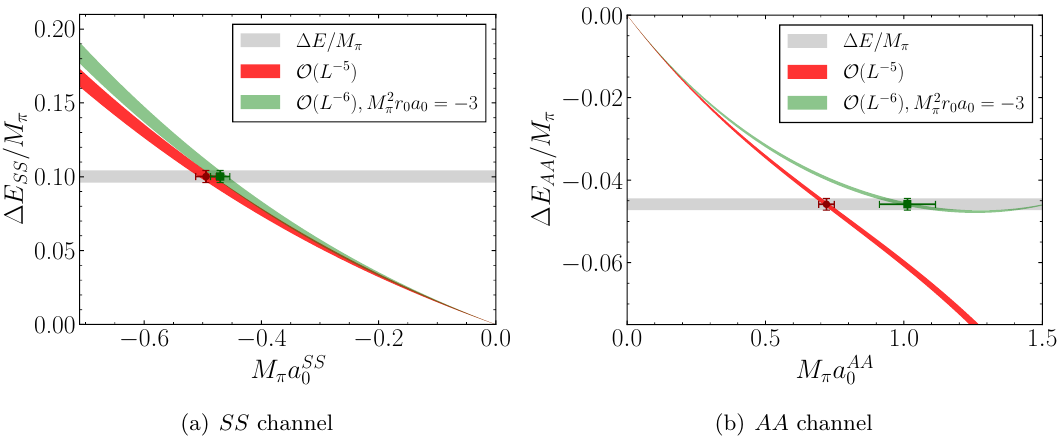
Figure 6 . Comparison between the O ( L − 5 ) (red) and O ( L − 6 ) (green) threshold expansion given in eq. (3.4). The left panel corresponds to the 3A10 ensemble in the SS channel, whereas the right one is the 3A11 ensemble and AA channel. The gray horizontal band is the energy level extracted from the lattice, and the points are the determinations of the scattering